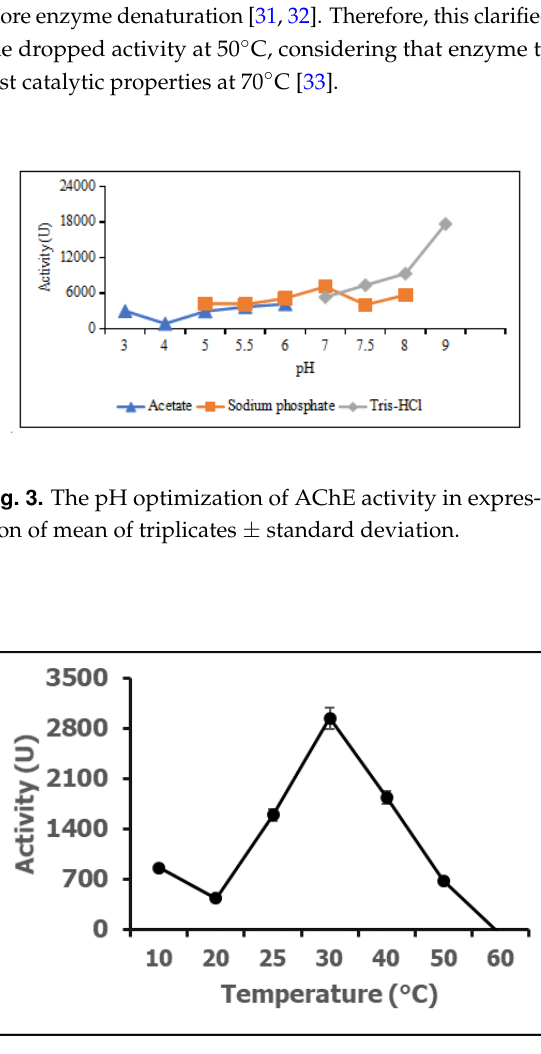
Fig. 4. The temperature optimization of AChE activity in expression of mean of triplicates ± standard